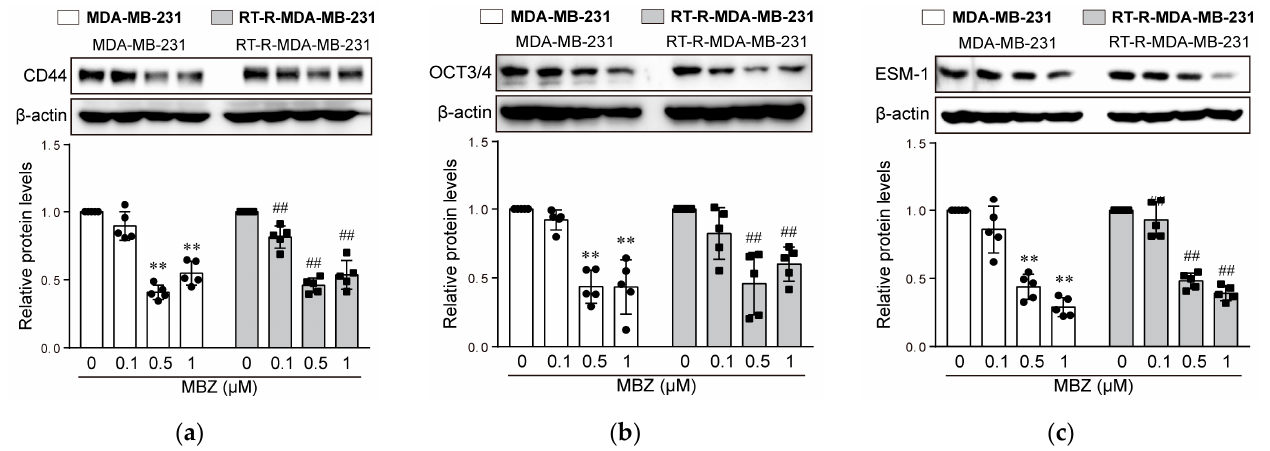
Figure 7. MBZ reduces the expression of cancer stem cell markers (CD44 and OCT 3/4) and ESM-1, which was enhanced in the RT-R-MDA-MB-231 cells compared to MDA-MB-231 cells. The cells were treated with the indicated concentrations of MBZ (0.1, 0.5, and 1 μ M) for 24 h. The expressions of ( a ) CD44, ( b ) Oct3/4, and ( c ) ESM-1 were determined in cell lysates by Western blotting. Data are expressed as the means ± SD from five independent determinations. ** p < 0.01 compared with control of MDA-MB-231 cells; ## p < 0.01 compared with control of RT-R MDA-MB-231 cells.